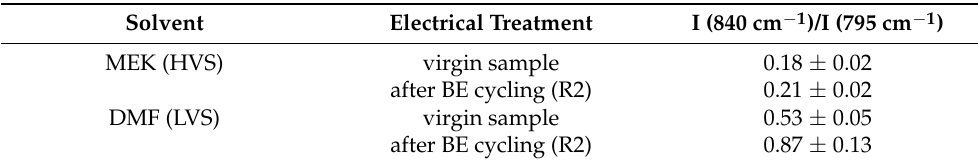
Figure 4. Raman spectra of virgin sample (black) and sample after two runs of BE cycling (red) of films processed from solvents DMF ( top ) and MEK ( bottom ). Table 5. Ratios for Raman band intensities at 840 cm − 1 and 795 cm − 1 , characteristic for polar and nonpolar crystalline structure in P(VdF),